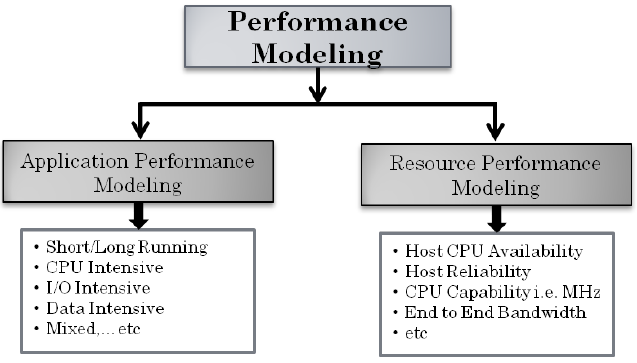
Figure 3. Types of performance modeling for large-scale distributed system.